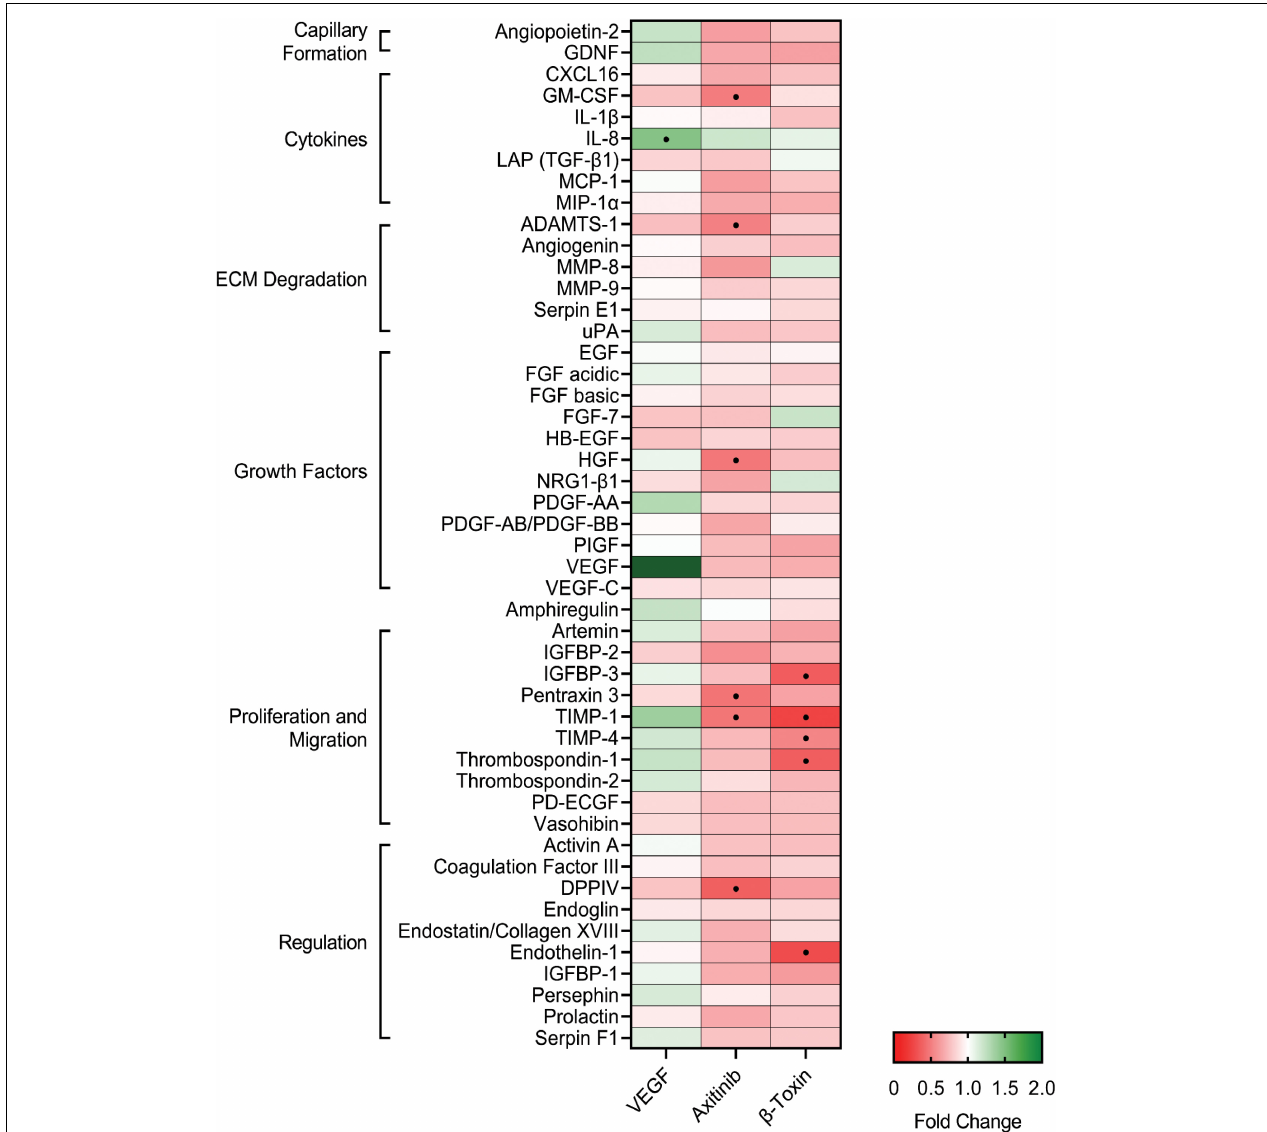
FIGURE 1 | β -toxin inhibits production of angiogenic proteins from human aortic endothelial cells in monolayer growth. Immortalized human aortic endothelial cells (iHAECs) grown to near confluency on gelatin-coated plates were treated with either VEGF (10 ng mL − 1 ), axitinib (30 µ M), or β -toxin (50 µ g mL − 1 ) for 24 h. Protein production was assessed by Proteome Profiler Human Angiogenesis Array Kit. Results are the mean fold change over untreated cells of three independent experiments conducted in duplicate. Angiogenic-related factors with a 50% increase ( > 1.5-fold change) or decrease ( < 0.5-fold change) from media